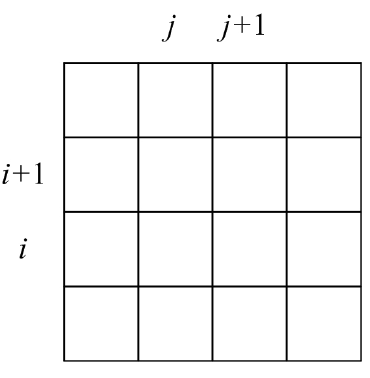
Fig. 2. The sub-regions division. Fig. 3. The pathes from different initial points.